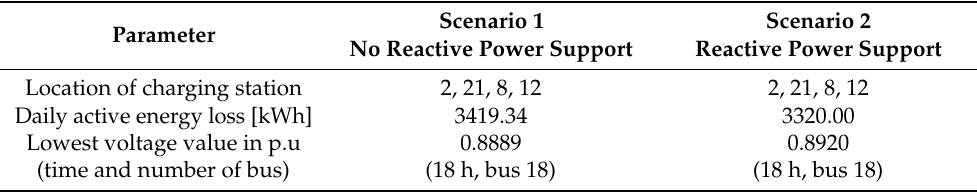
Table 5. Locations for EVCSs and network parameters for the two scenarios.